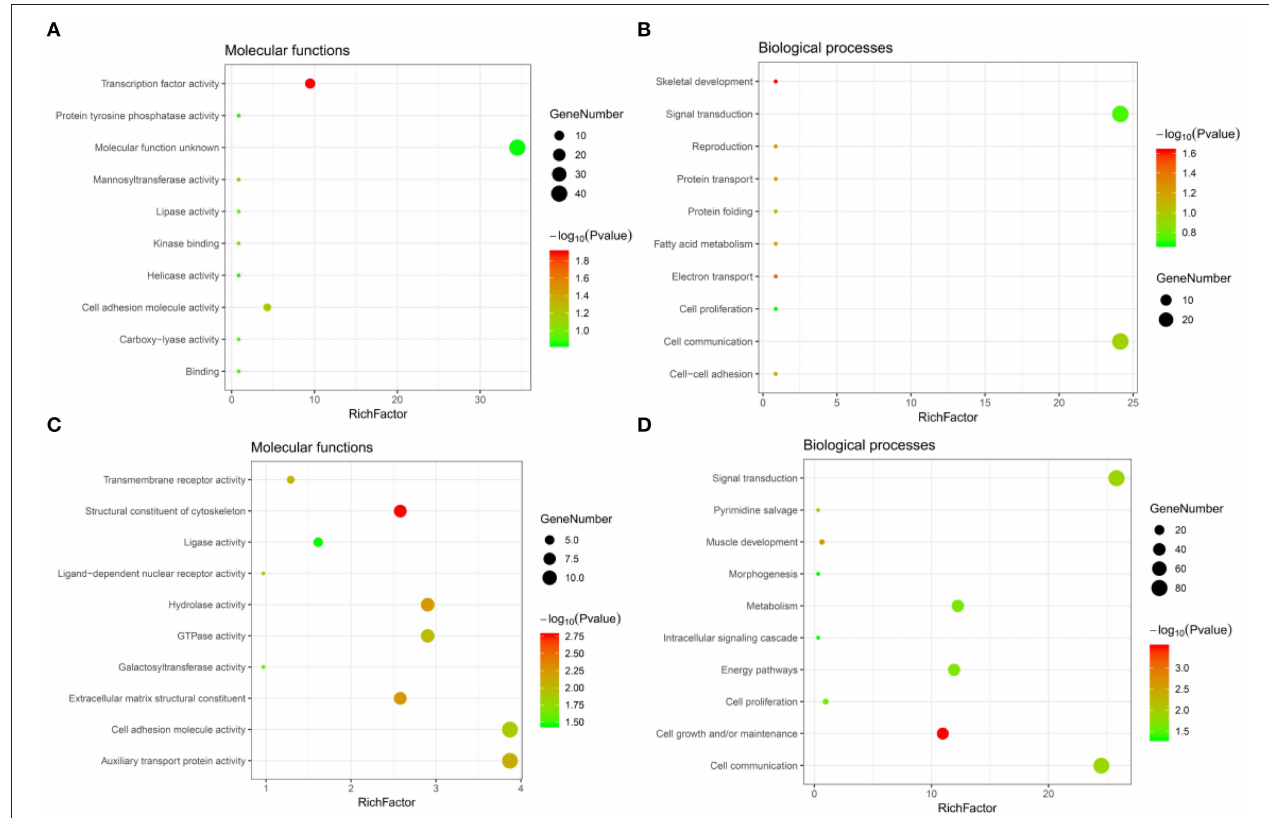
FIGURE 4 | GO annotations analysis of the intersecting genes. (A,B) Top 10 elements significantly enriched in the GO categories by intersecting genes of downregulated genes after CORO2A silencing and genes positively correlated with CORO2A expression: (A) molecular functions, (B) biological processes. (C,D) Top 10 elements significantly enriched in the GO categories by intersecting genes of upregulated genes after CORO2A silencing and genes negatively correlated with CORO2A expression: (C) molecular functions, (D) biological processes. Significantly enriched elements are indicated in Y -axis. Rich factor in the X -axis represents the enrichment levels. The larger value of Rich factor represents the higher level of enrichment. The color of the dot stands for the different P -value and the size of the dot reflects the number of target genes enriched.